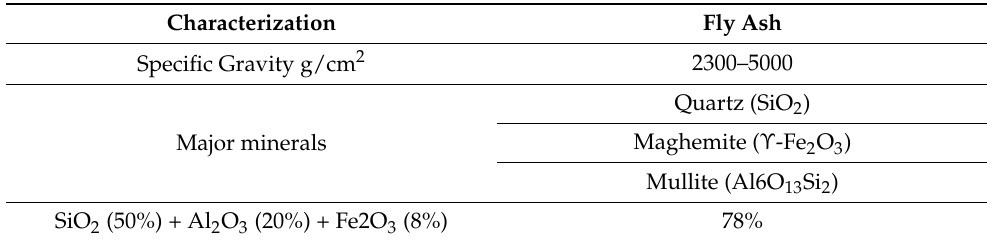
Table 3. Properties of fly ash .